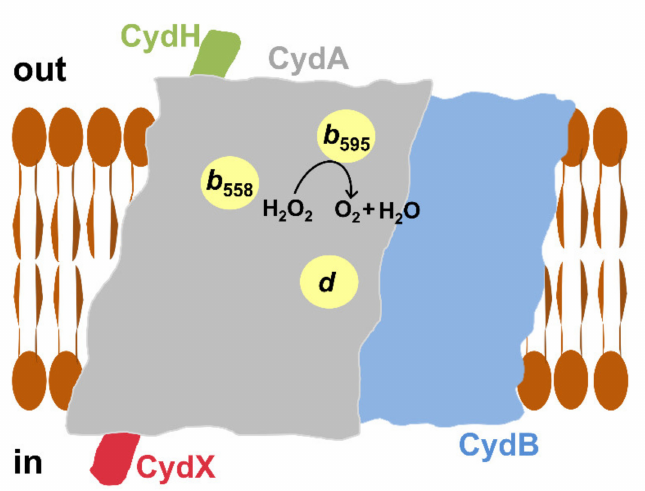
Figure 4. Proposed catalase-like activity of cytochrome bd -I and cytochrome bd -II from E. coli . Shown is the scheme for bd -type enzyme arrangement in the E. coli membrane bilayer based on the solved bd -I structure [28,29]. The oxidase consists of four different subunits, CydA, CydB, CydX, and CydH. CydA carries three hemes, b 558 , b 595 , and d